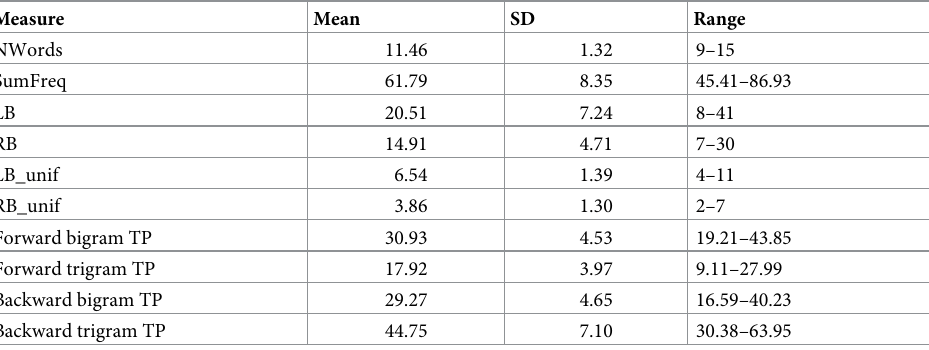
Table 1. Descriptive statistics of sentence-level predictors (n = 160; all measures summed per sentence).